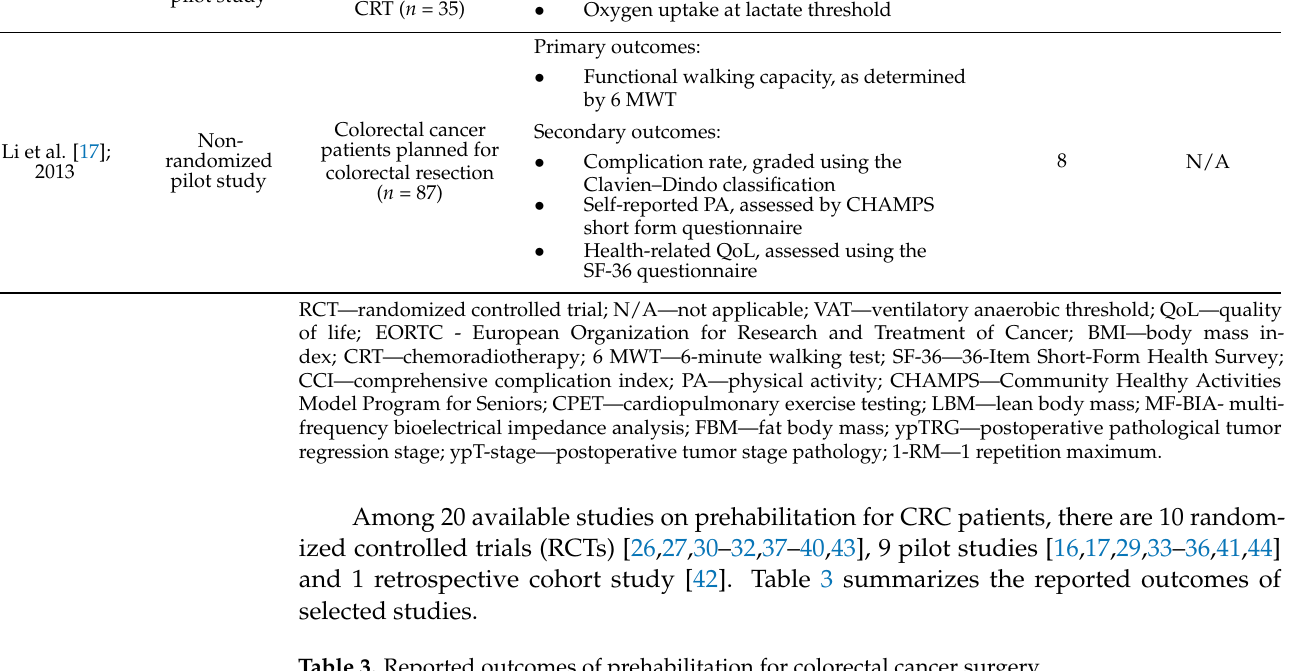
Table 3. Reported outcomes of prehabilitation for colorectal cancer